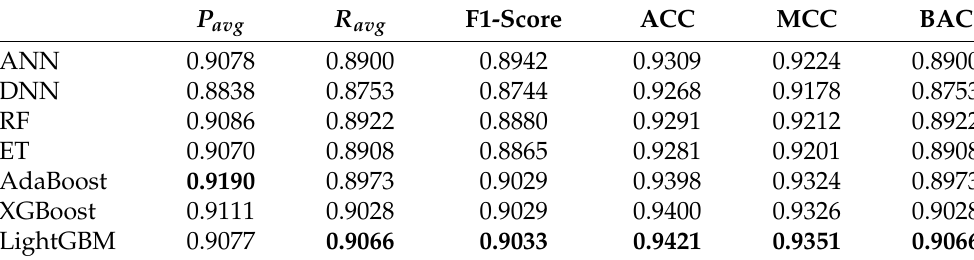
Table A2. Measured metrics for permission set